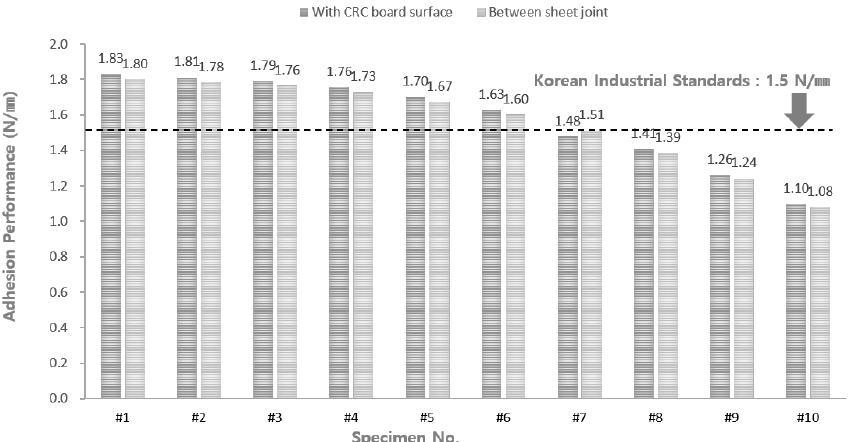
Figure 12. Adhesion performance test result of the NaCl-treated sample.